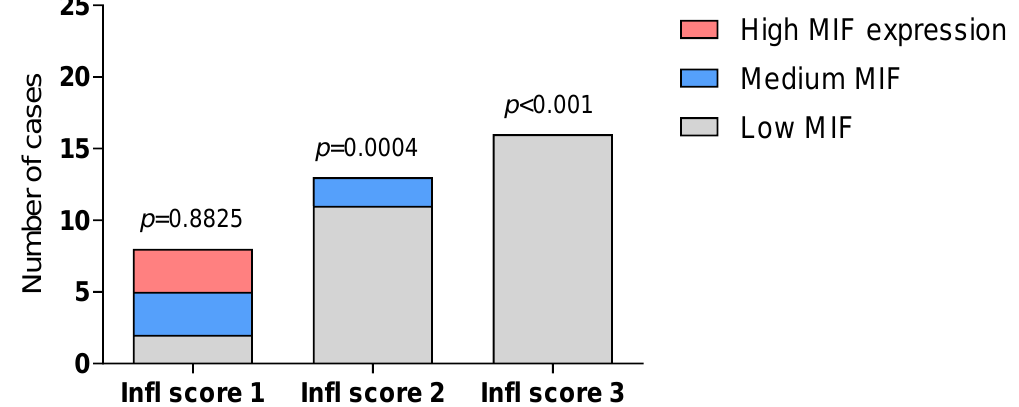
Figure 4. Relative proportions of DLE samples with different expression of MIF and increasing inflammatory score. Thirty-seven patients with DLE were recruited for this study. Biopsies were performed after a six-month wash-out period from topical treatments. Hematoxylin and eosin staining was used for histopathological evaluation. Statistical analysis was performed using the Fisher’s chi-square test. Infl score: Inflammatory score. No correlation was found between MIF levels and patient clinical data, including age, sex, BMI, and response to treatment (Table